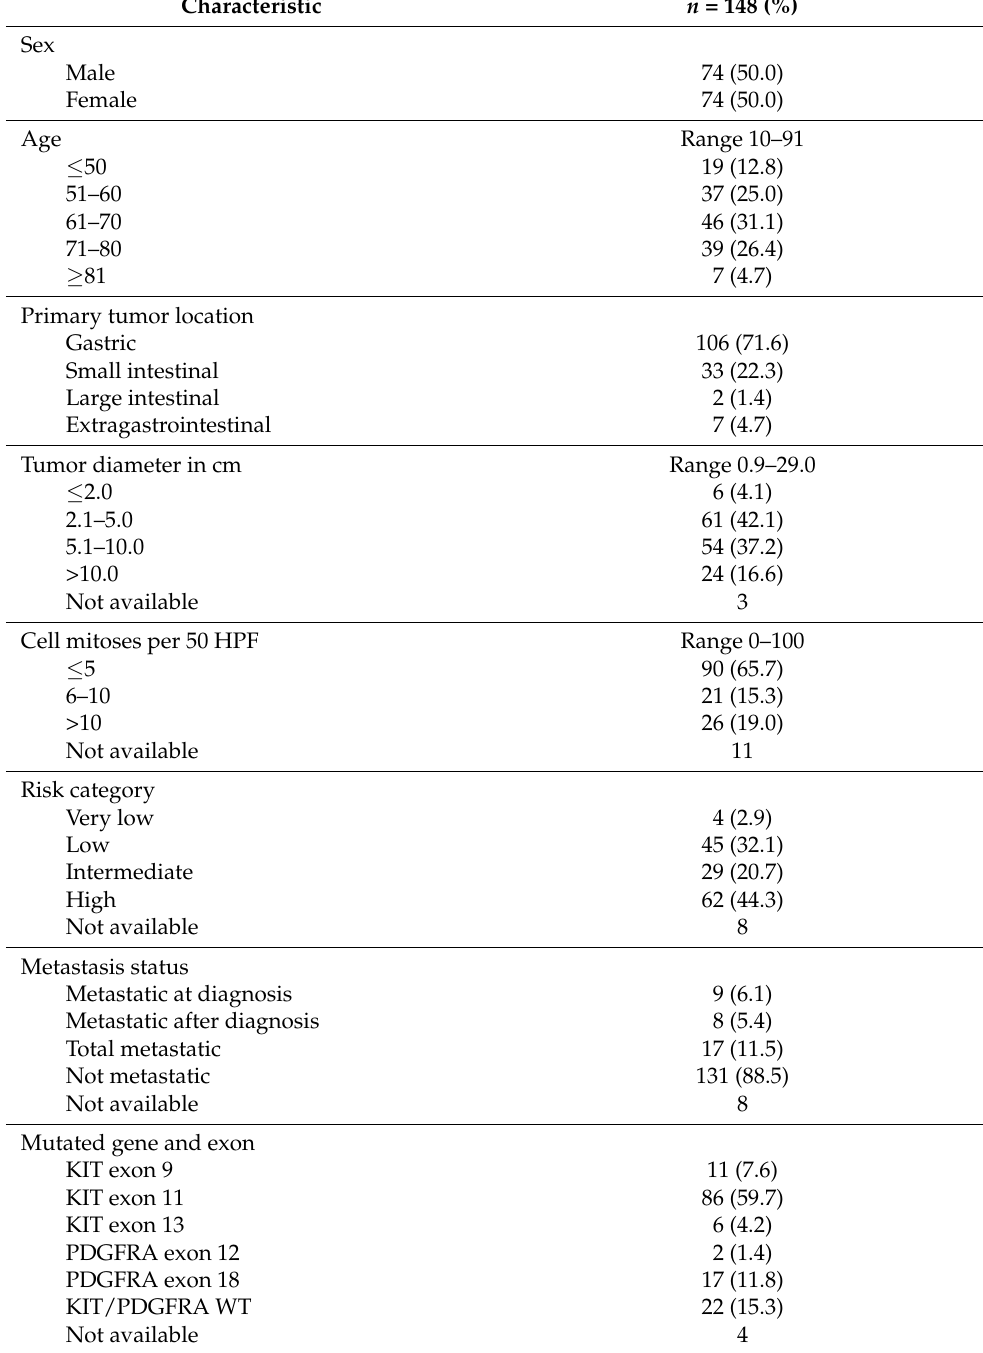
Table 2. Clinicopathological data of the 148 GIST patient